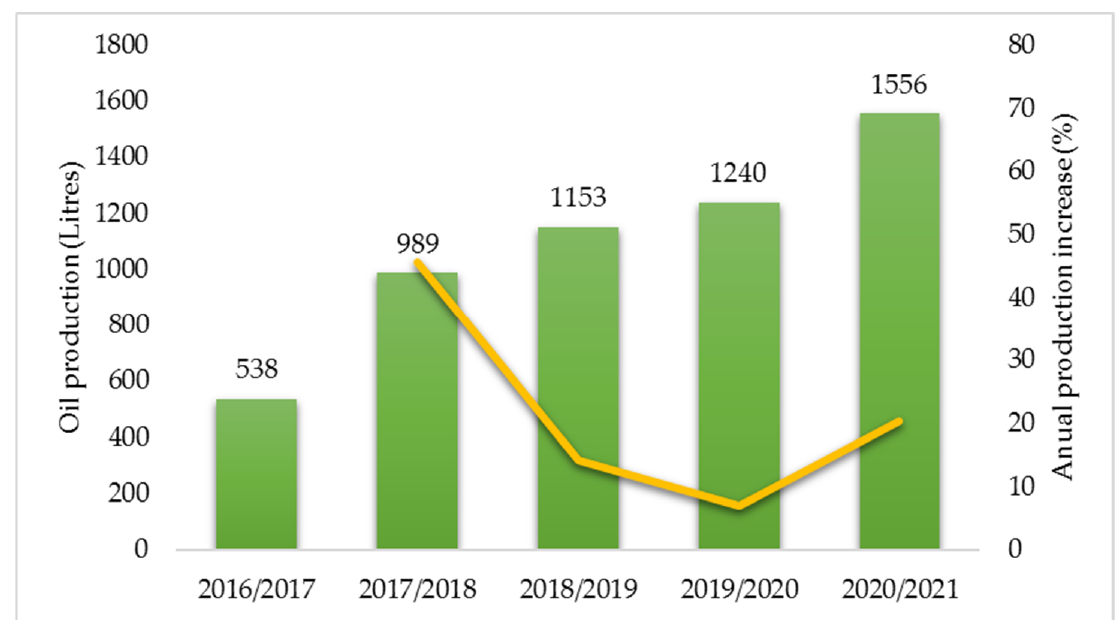
Figure 5 . Annual olive oil production in Extiercol project. Green bars represent total production (Litres) and yellow line annual increase (%).